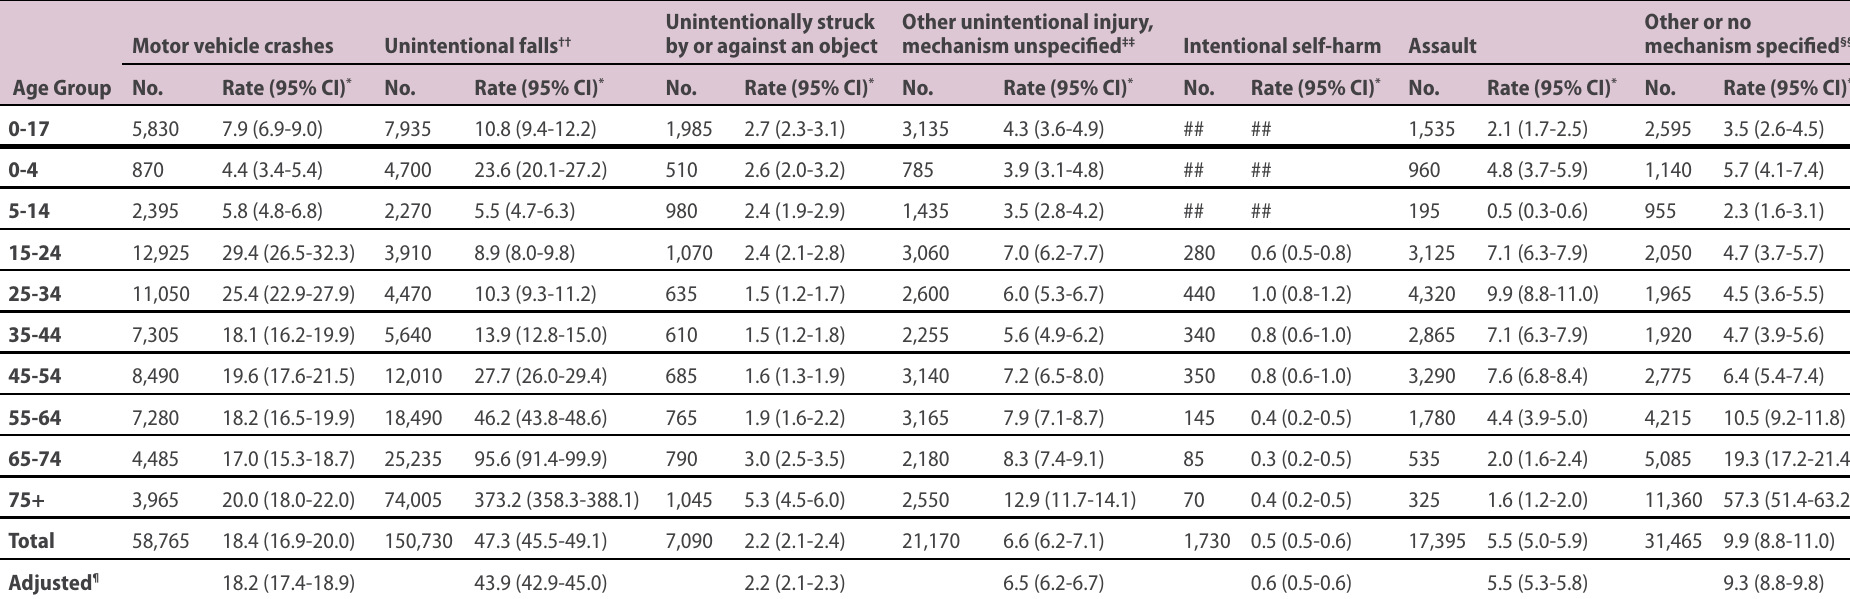
TABLE 3: ESTIMATED NUMBER AND RATE OF TRAUMATIC BRAIN INJURY–RELATED HOSPITALIZATIONS, BY AGE GROUP AND MECHANISM OF INJURY, 2014